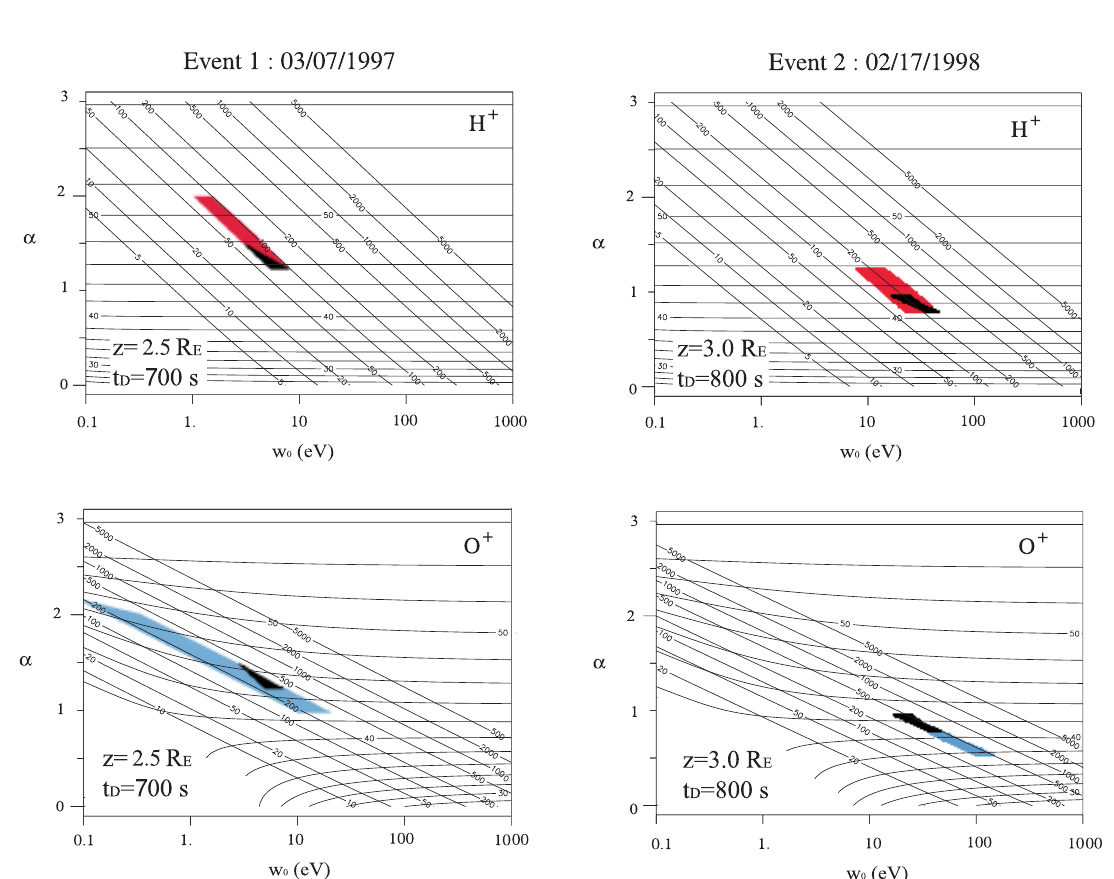
Fig. 7. Graphical method used to determine the parameters associated with the altitude dependence of ion transverse heating.